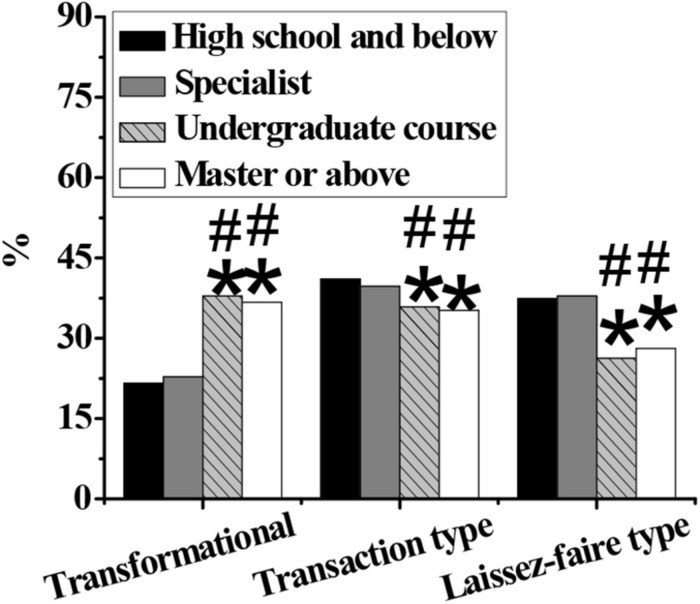
Differences in educational background between different entrepreneurial psychological leadership styles. Note: An asterisks (*) indicates that there is a statistically significant difference (p < 0.05) compared with high school degree and below; A number sign (#) indicates that the difference is statistically significant compared with the junior college degree (p < 0.05).